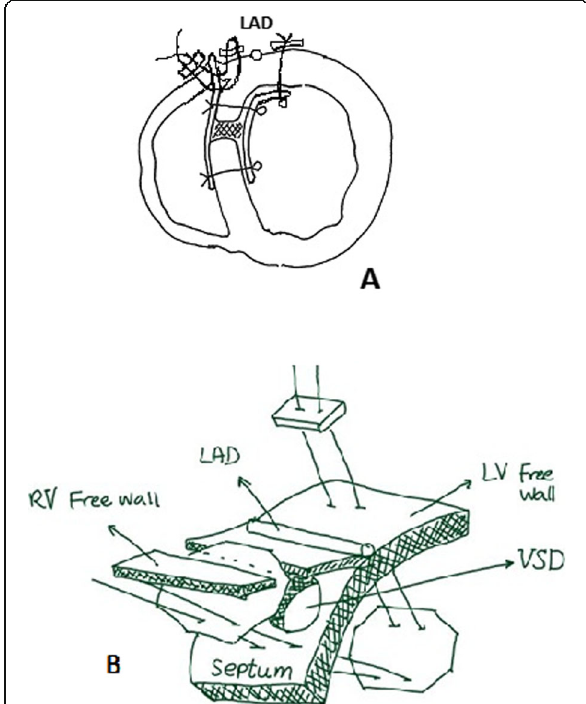
Fig. 1 Sandwich technique with use of biological glue